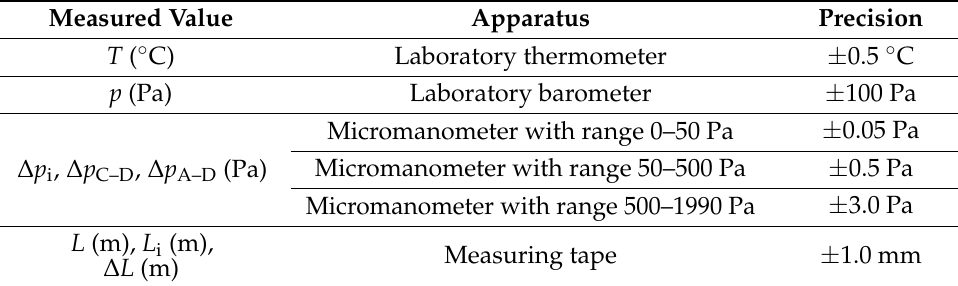
Table 1. Experimental apparatus and its precision